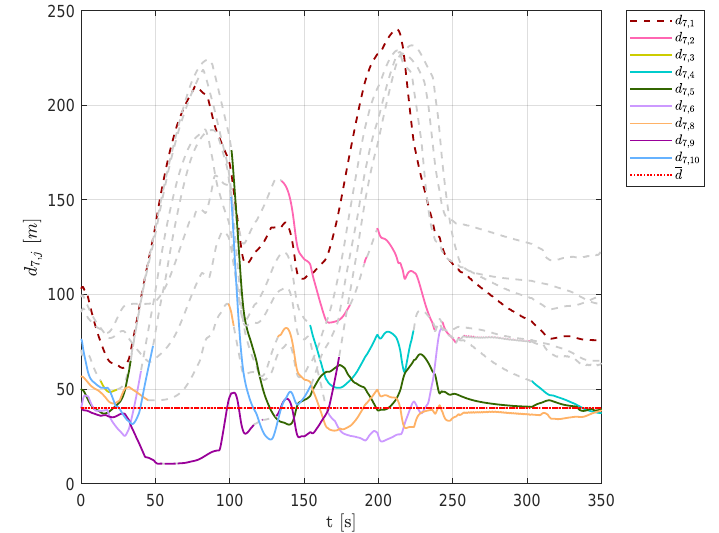
Figure 23. Scenario #2—10 aircraft: distances between UAV 7 and the other swarm vehicles. Solid lines are used for visible aircraftand dashed gray lines are employed whenever they are no longer visible, whereas dashed colored lines are used for never-visible UAVs. The desired distance is highlighted using a dotted red